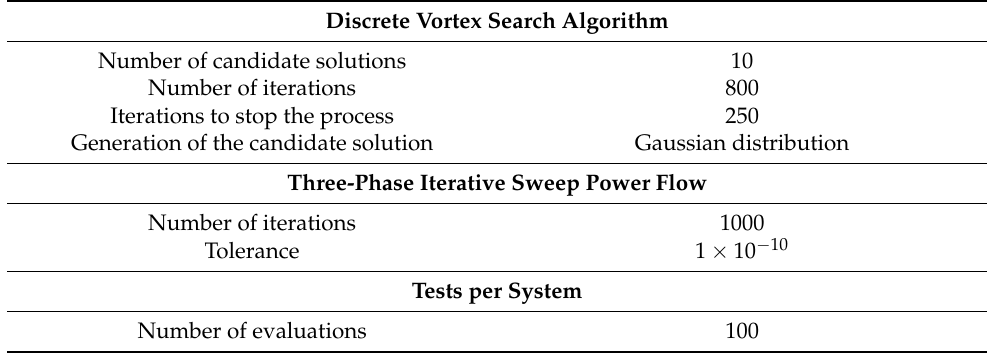
Table 10. Parameters used to implement the DVSA